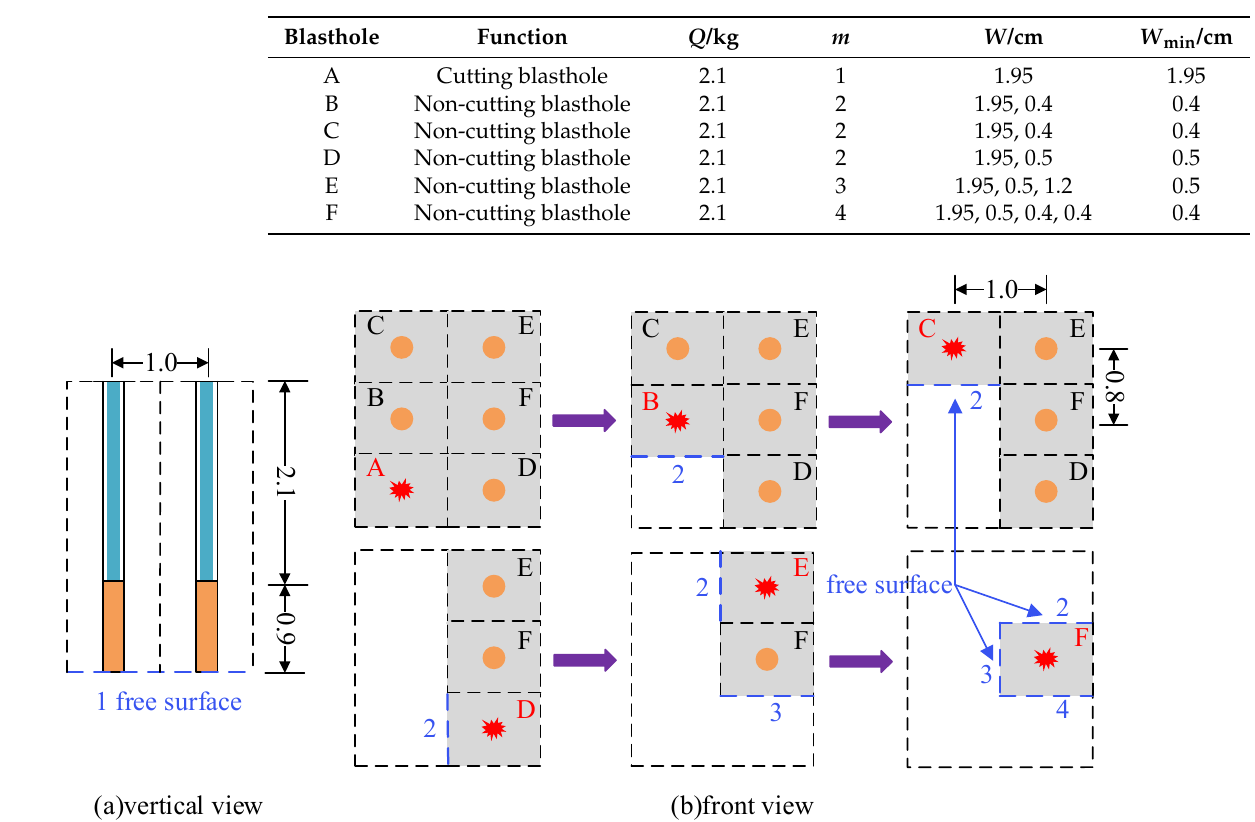
Figure 3. Detonation sequence and blasting free surface change.